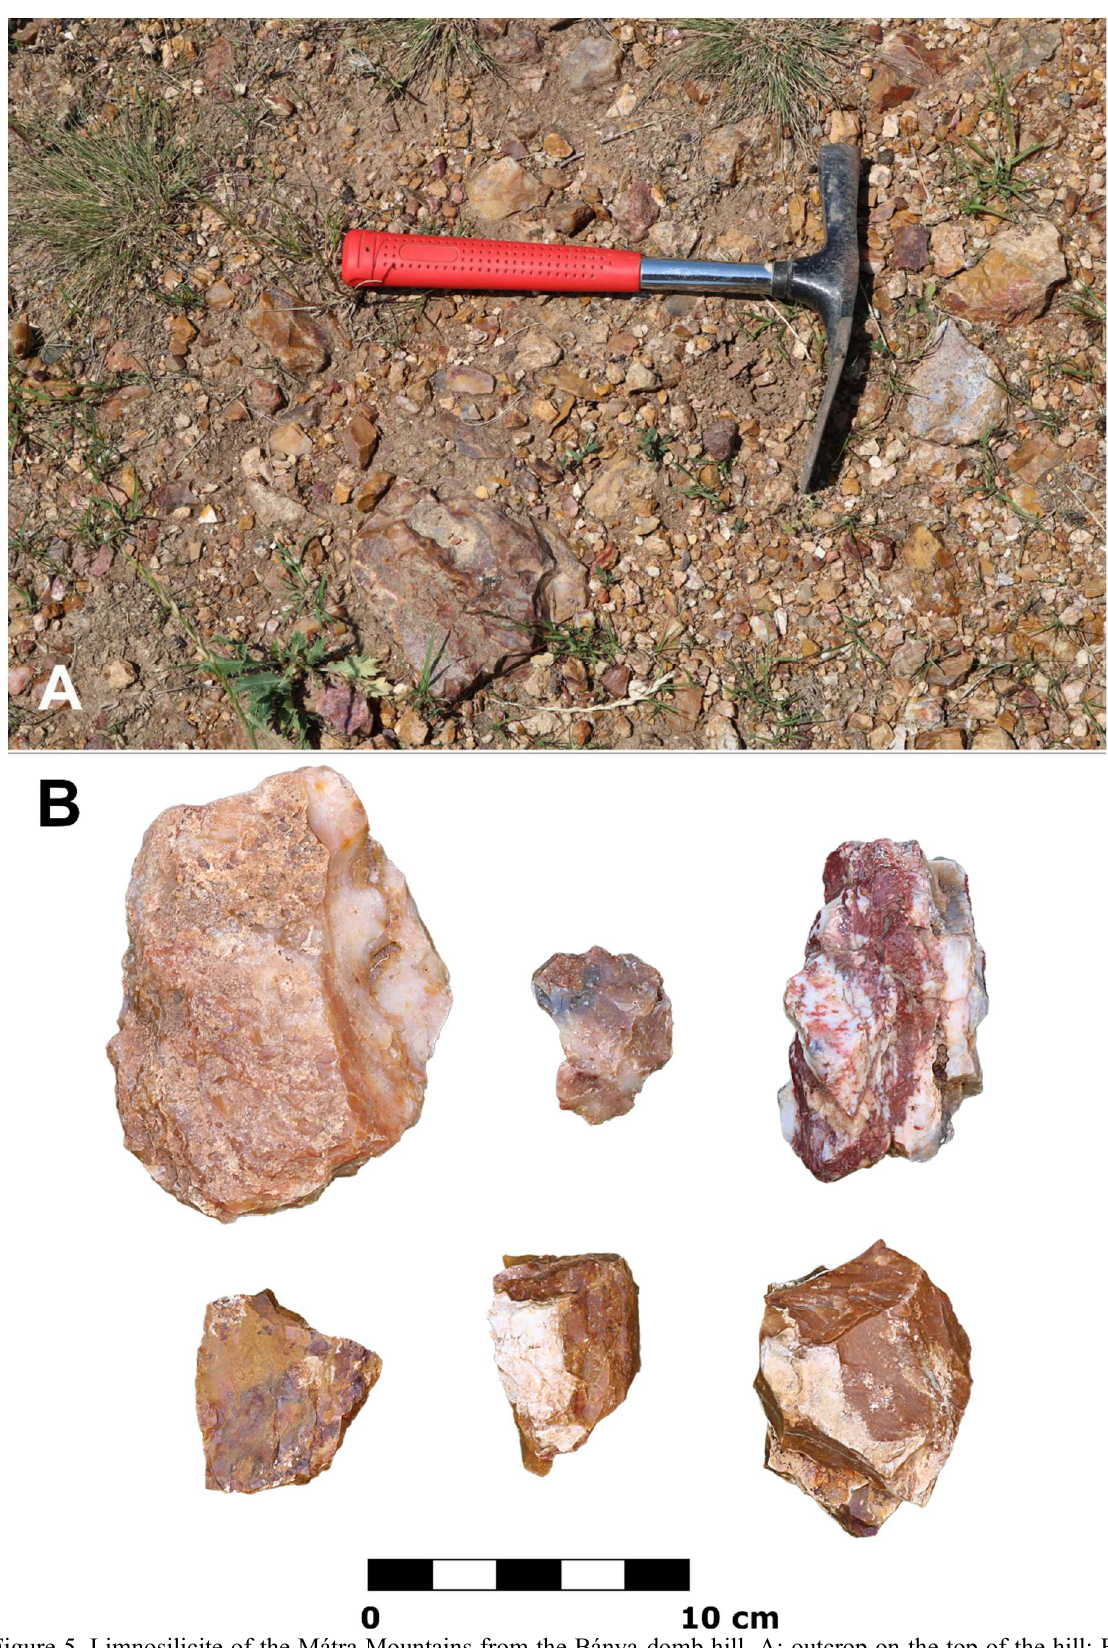
Figure 5. Limnosilicite of the Mátra Mountains from the Bánya-domb hill. A: outcrop on the top of the hill; B: raw material blocks. (Photo and CAD by Z. Mester and N. Faragó) Figure 5. Limnosilicite de la montagne de Mátra provenant de Bánya-domb. A: l’affleurement au sommet de la colline; B: blocs de matière première. (Cliché et DAO: Zs. Mester et N. Journal of Lithic Studies (2022) vol. 9, nr. 1, 44 p. DOI: https://doi.org/10.2218/jls.7475